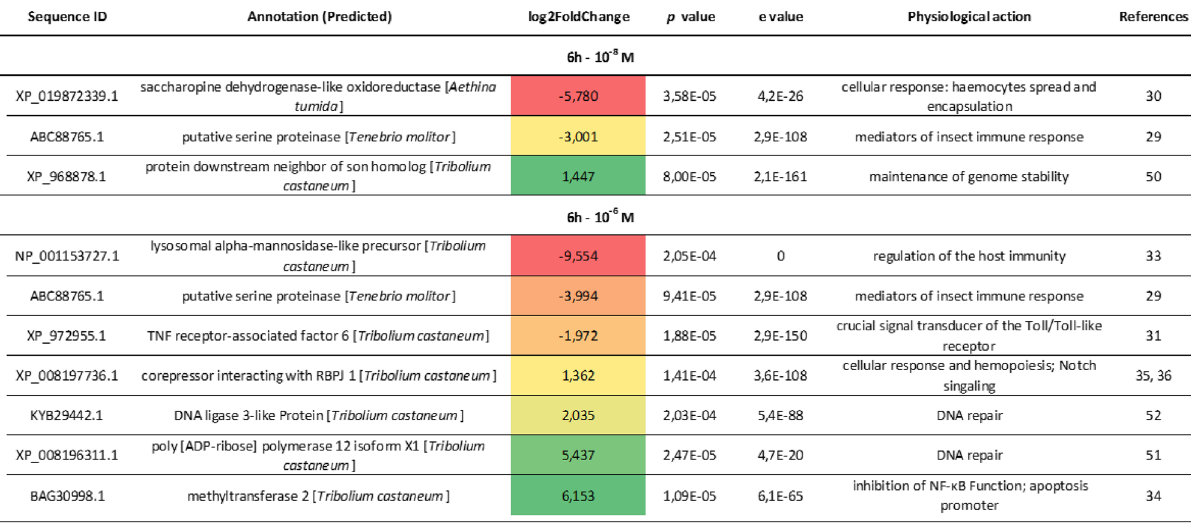
Table 1. Differential expression of selected immune-related transcripts in the fat body and haemocytes of T. molitor 6 h after Tenmo-TRP-7 treatment at concentrations of 10 –8 and 10 –6 M. Gradient from red to green: Fold change values represent the increased (green) or decreased (red) abundance of transcripts (adjusted p value of < 0.05) compared to the control individuals that were injected with physiological